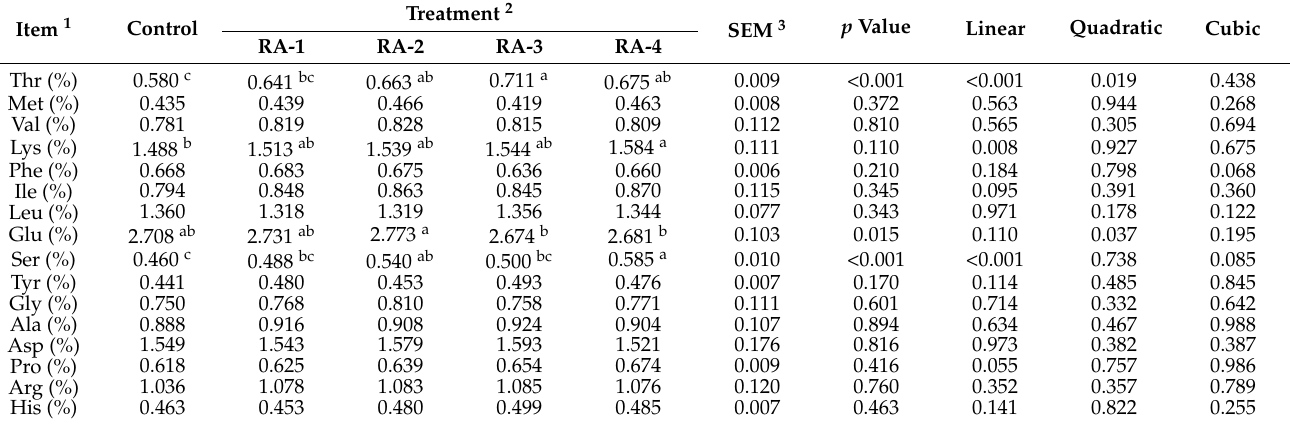
Table 7. The effect of dietary supplementation with rosmarinic acid (RA) on muscle amino acids of